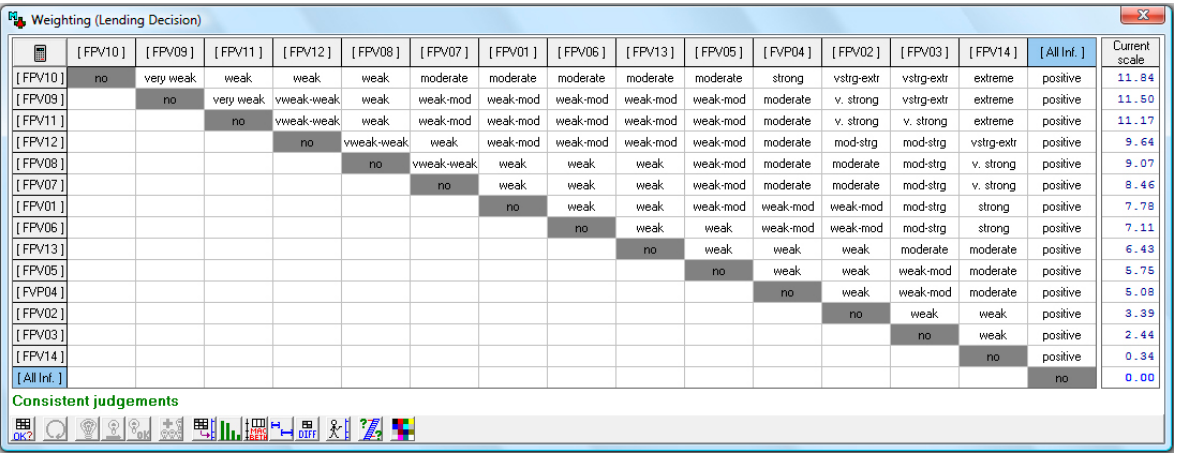
Fig. 3. Matrix of comparisons and proposed trade-offs [M-MACBETH software] (Ferreira et al. 2014b)